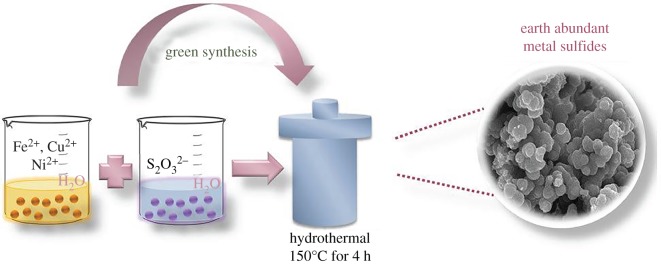
Schematic illustration of the hydrothermal synthesis of FeS2, CuS and NiS2 powders. Adapted from Springer.